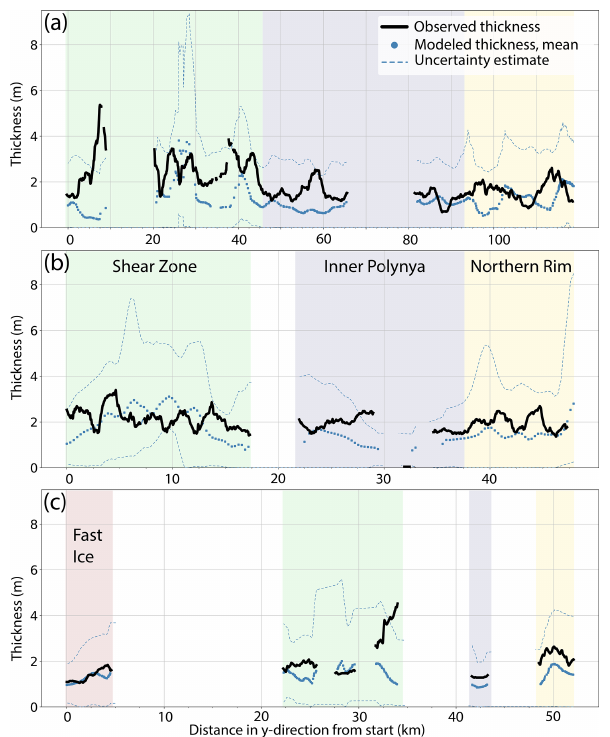
Figure 10. Modeled and observed thickness profiles across the FYI from south (left) to north (right) of (a) the northern profile, (b) the central profile, and (c) the eastern profile. The four zones are marked with colors. Modeled mean thicknesses are given with the uncer- tainty derived from the tracking (Sect. 2.5). Note different x -axis scales based on different lengths of profiles (see Fig.